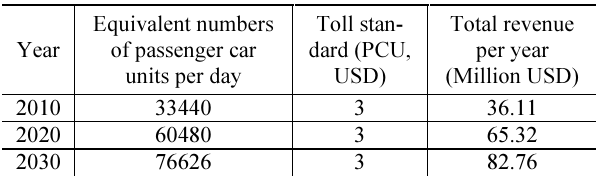
Table 1. Estimation of PCUs and revenue of Nanjing